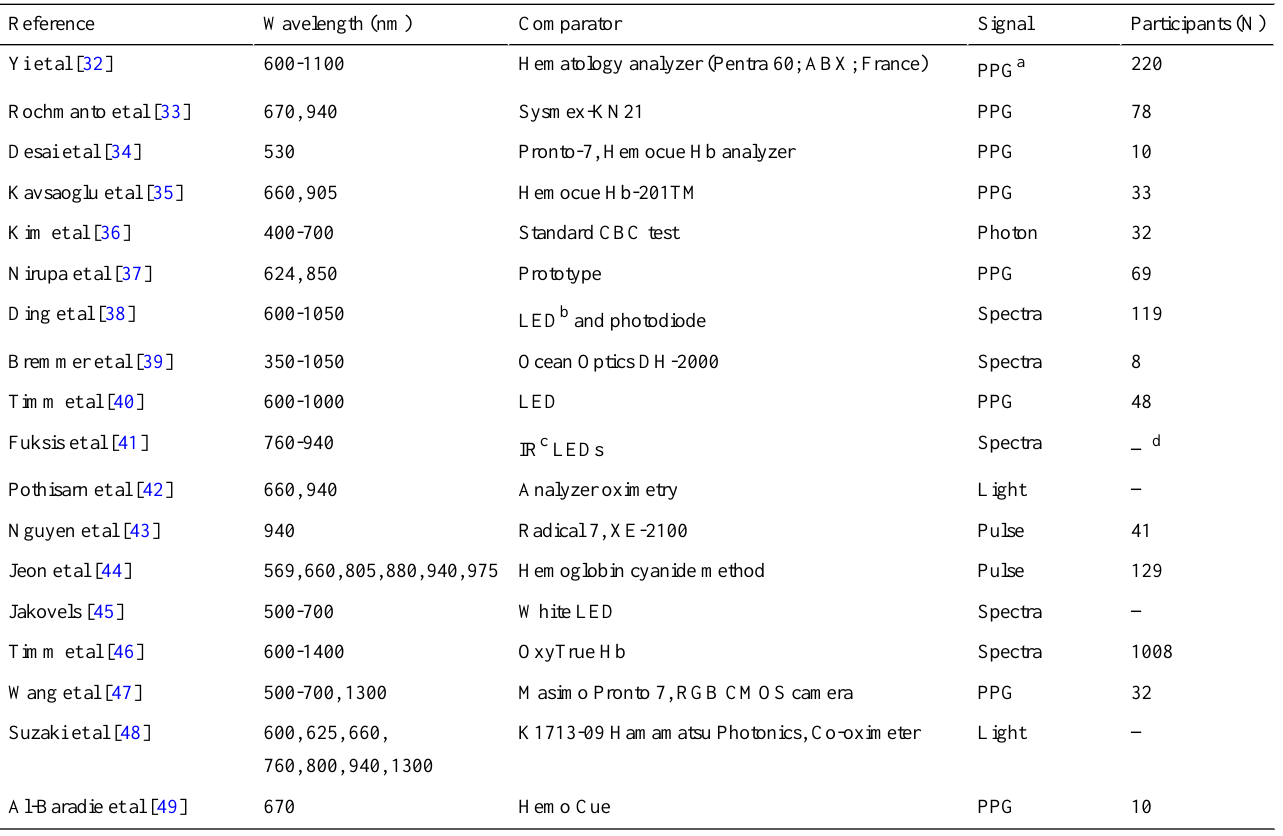
Table 1. Summary of spectra-based techniques proposed for noninvasive hemoglobin